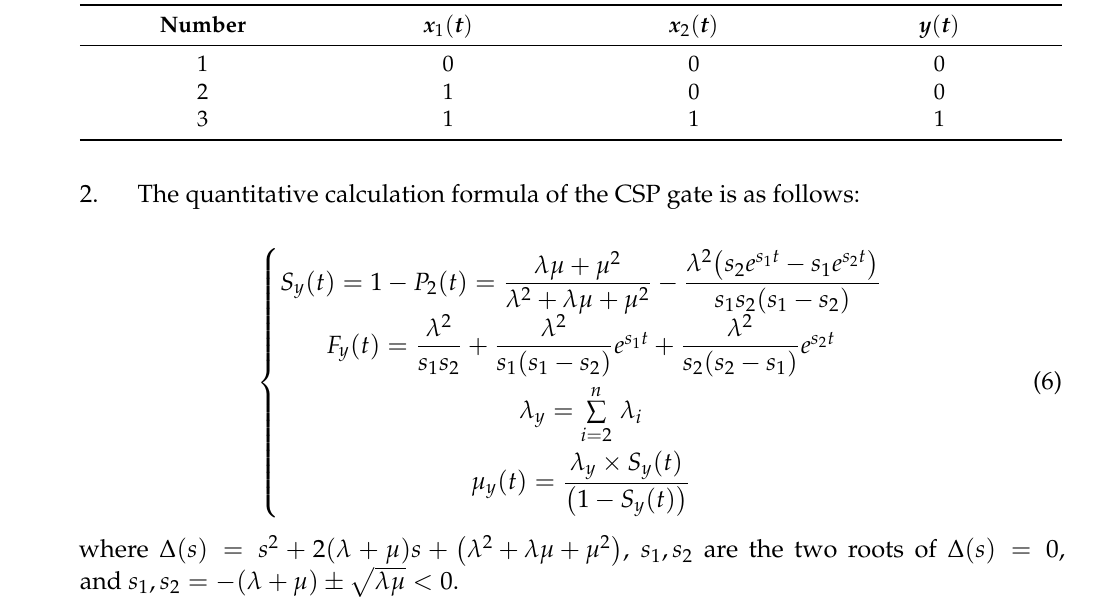
Figure 3. The transformation of the CSP gate into a Markov model. Table 4. The quantitative operation rules of the CSP